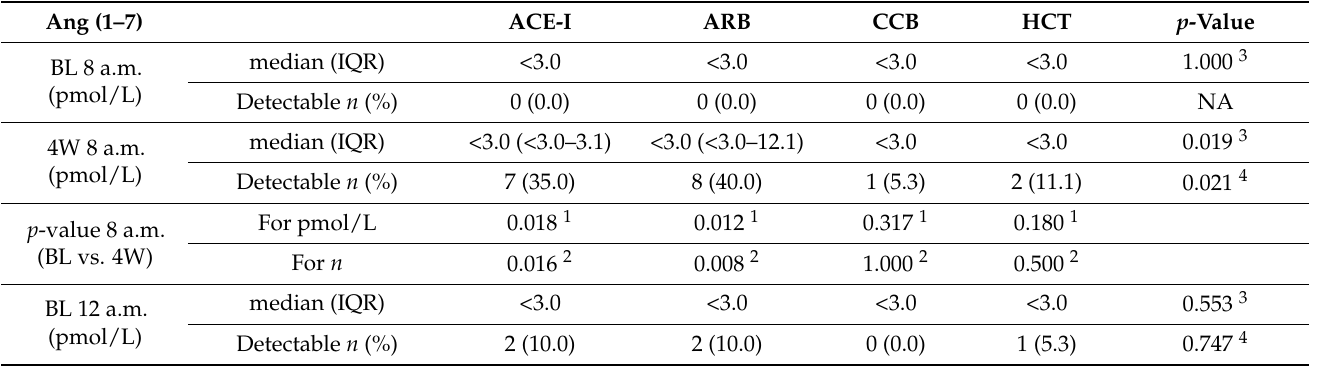
Table 4. Ang (1–7) equilibrium concentrations at baseline (BL) and during follow up (4W) in the morning (8 a.m.) and at noon (12 a.m.) for each assigned drug, presented as the median (interquartile range (IQR)). Ang (1–7) ACE-I ARB CCB HCT p